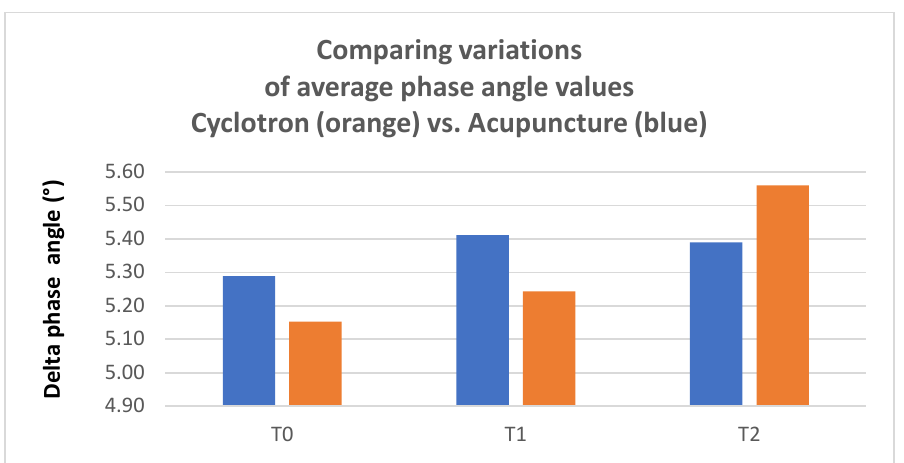
Figure 10. Average phase angle increases at T1 and increases further at T2 after exposure to ion cyclotron emission, while it increases at T1 and decreases at T2 after acupuncture at the same acupuncture points. It increases more after exposure to ion cyclotron emission than after acupuncture.